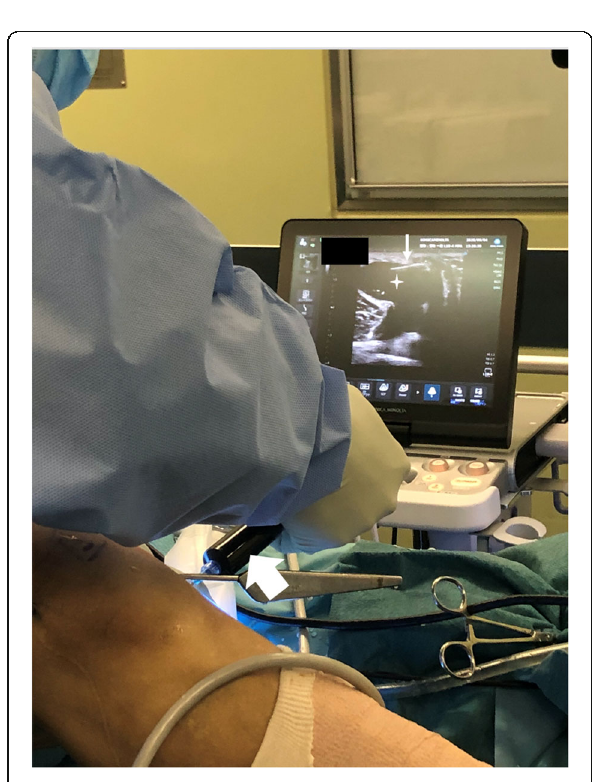
Fig. 3 A contrast dye (indigo carmine, broad white arrow) is injected into the popliteal cyst (star) percutaneously using ultrasonography. The 23-gauge needle (narrow white arrow) is clearly visible on the ultrasound